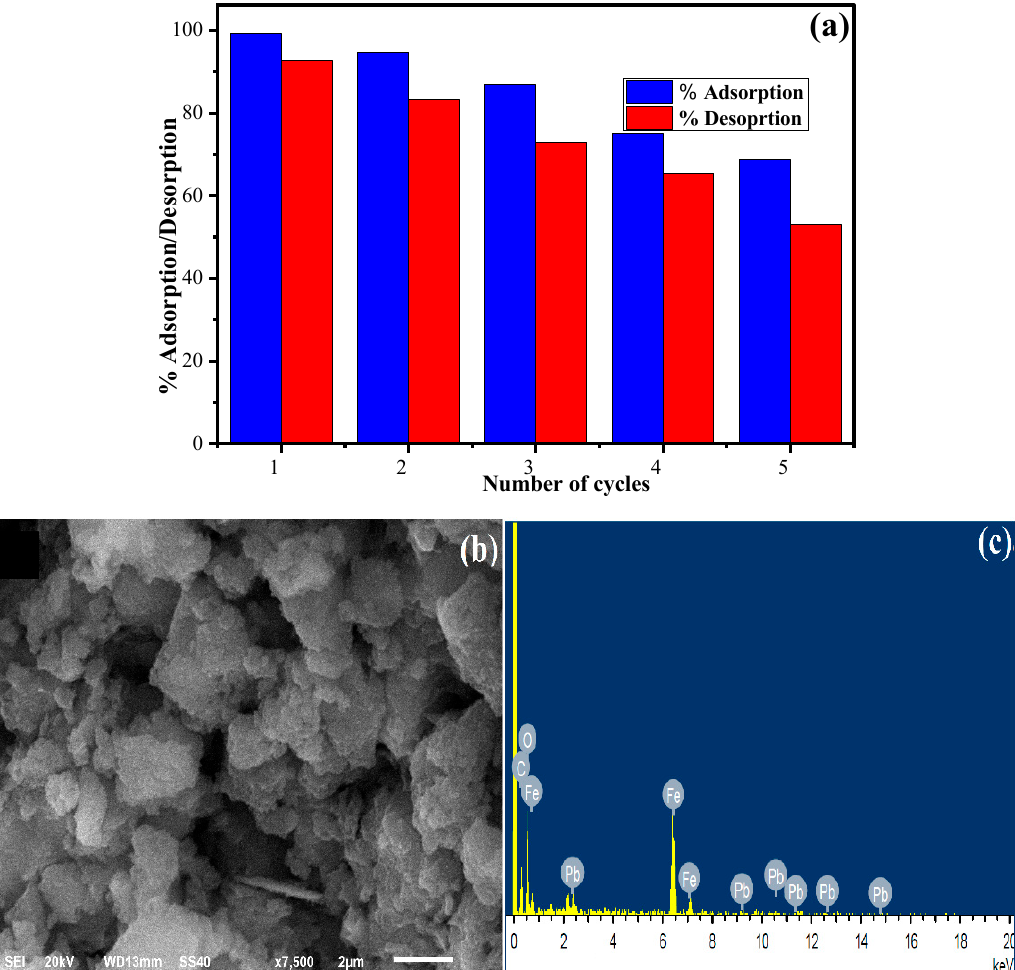
Figure 11. ( a ) Adsorption-desorption bar graph for regeneration of XGFO toward Pb (II) adsorption, ( b , c ) SEM-EDX spectra of Pb (II)-loaded XGFO at optimized conditions.